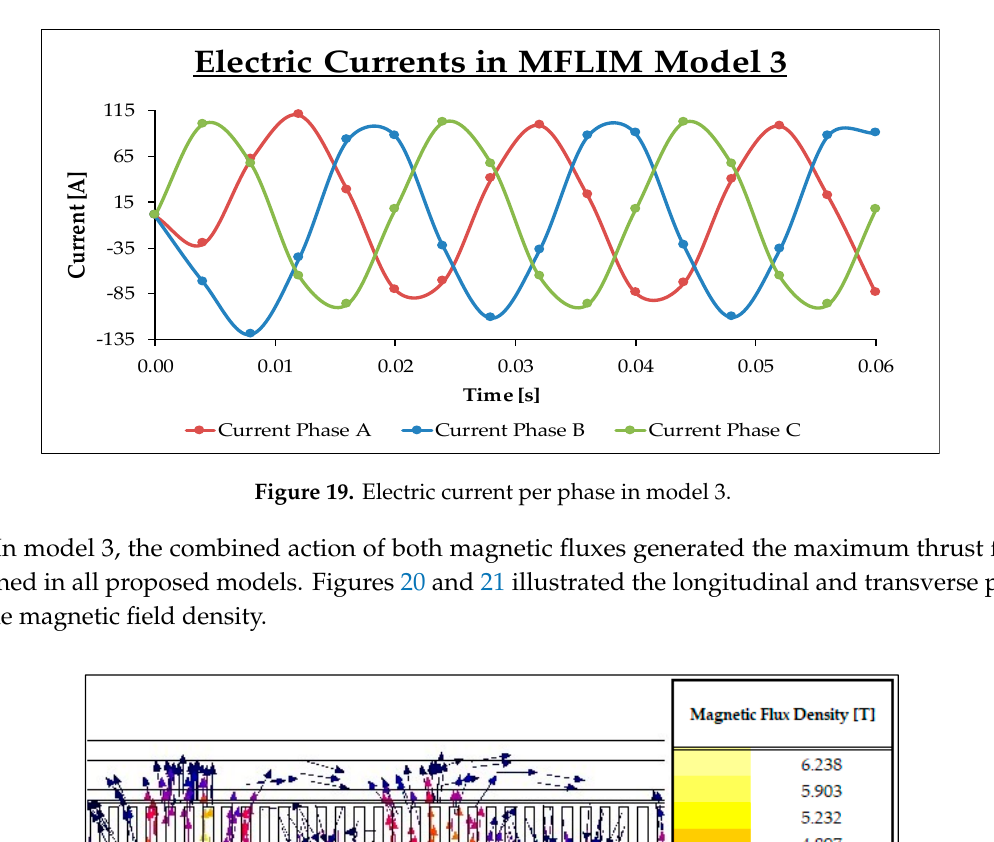
Figure 20. Longitudinal magnetic field density.